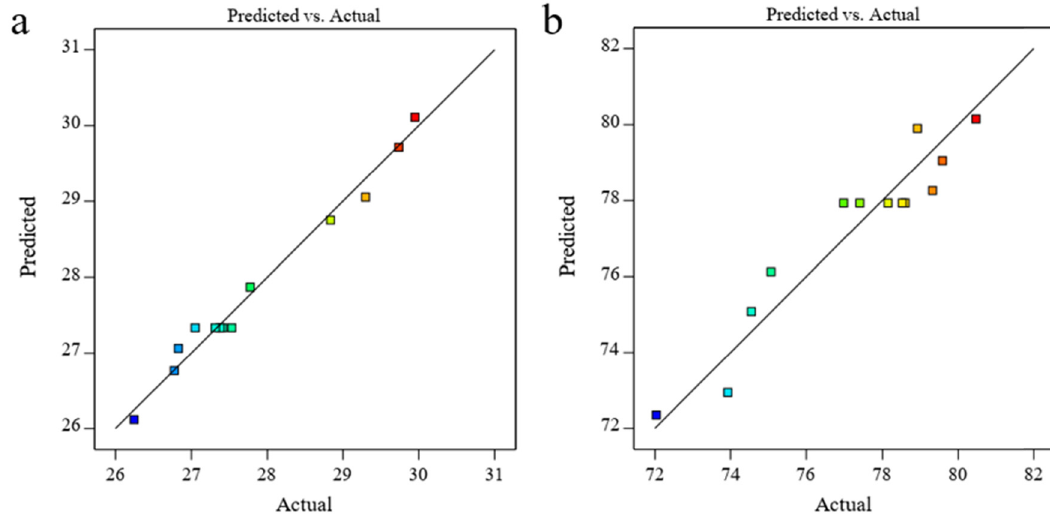
Figure 3: The relationship between the actual data of the model and the predicted data: ( a ) yield, ( b ) fi xed carbon